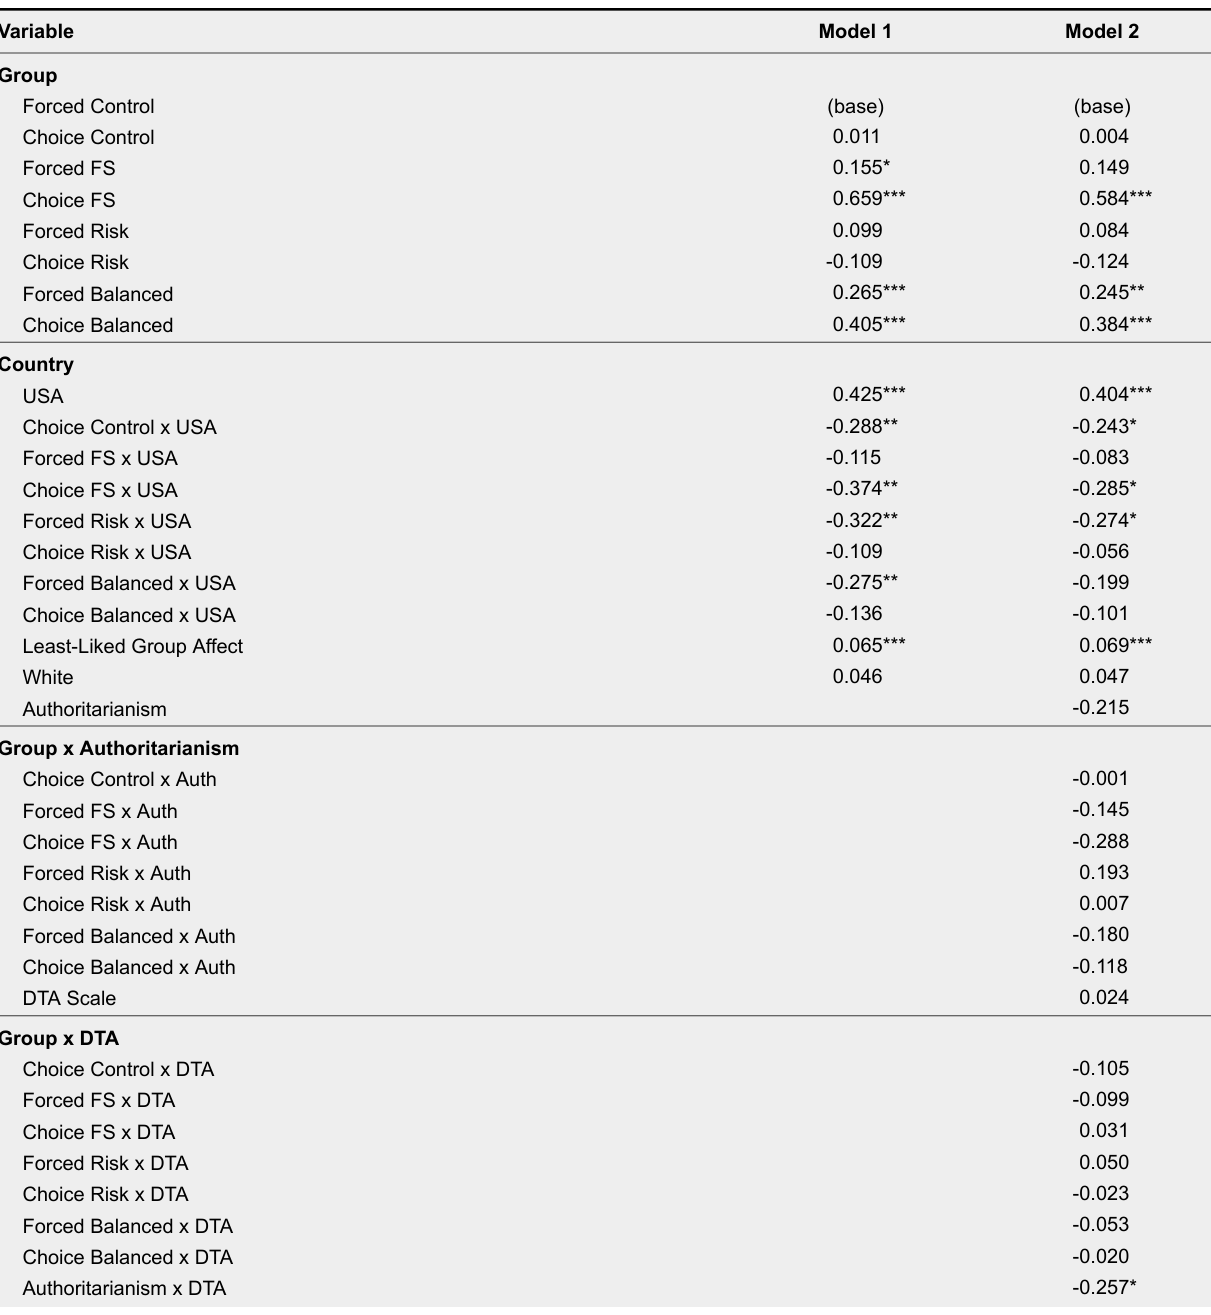
Conditional Effects of Political Messages on Political